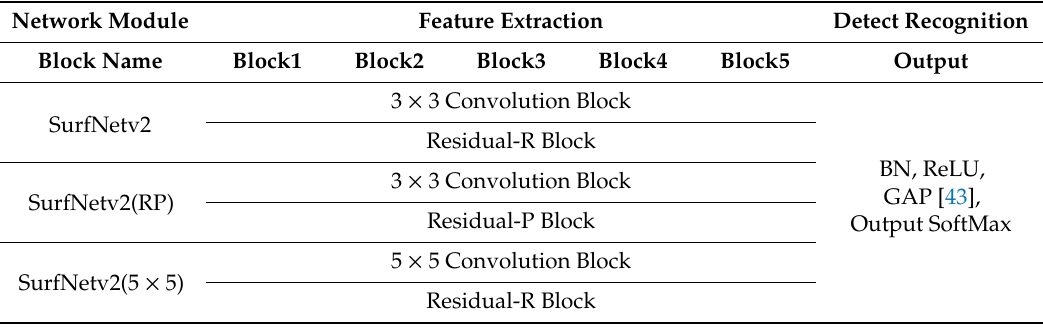
Table 1. Di ff erent network architectures of the proposed SurfNetv2